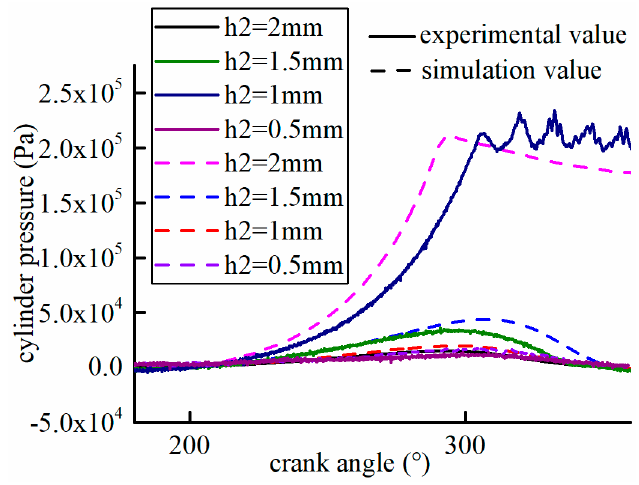
Figure 7. The gas resultant force curve of different backflow clearances.